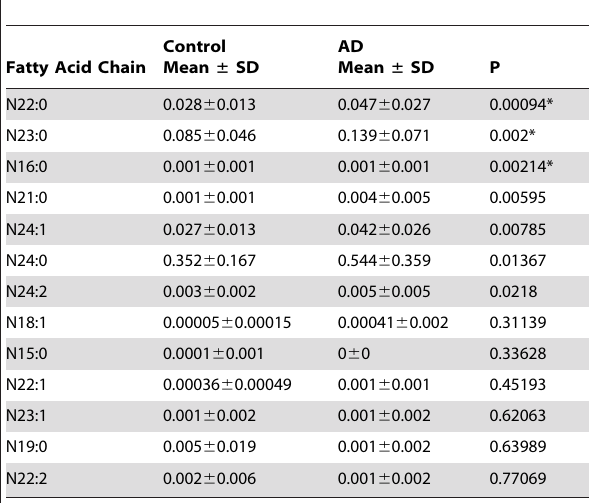
Table 5. Ratios of ceramides to sphingomyelins with same fatty acid chain show multiple significant differences between Alzheimer’s patients and controls a